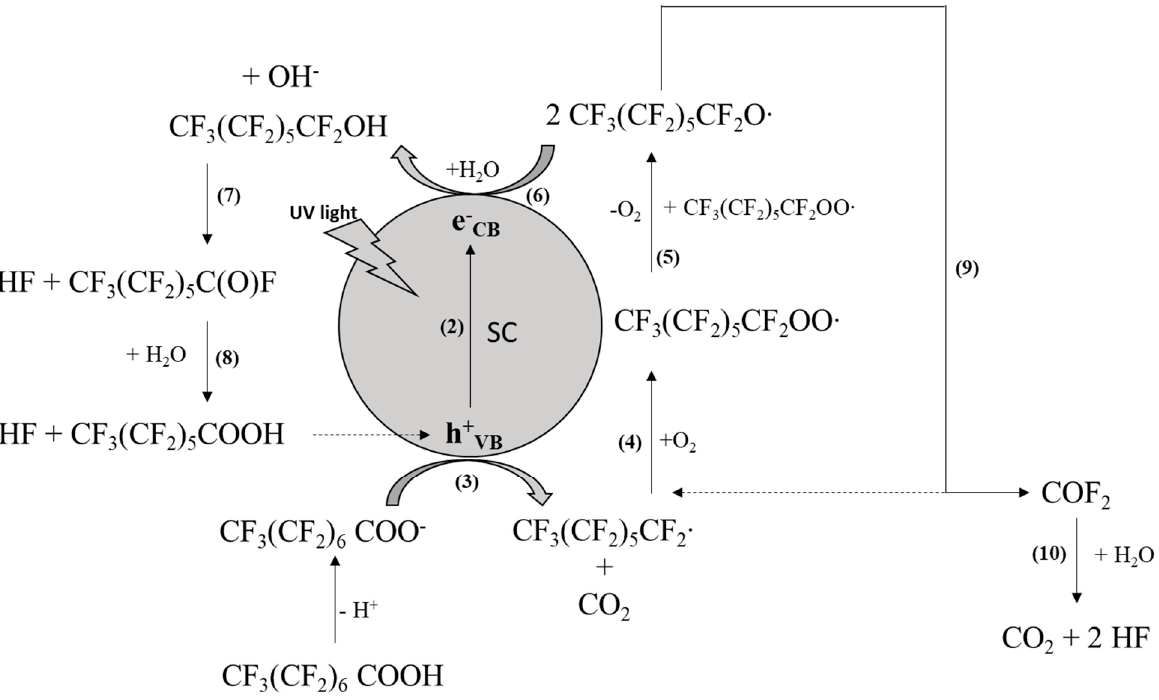
Figure 6. A hypothesized degradation mechanism of PFOA. Dashed lines indicate that the Cn product undergoes the same path, reducing the number of carbon atoms step by step.